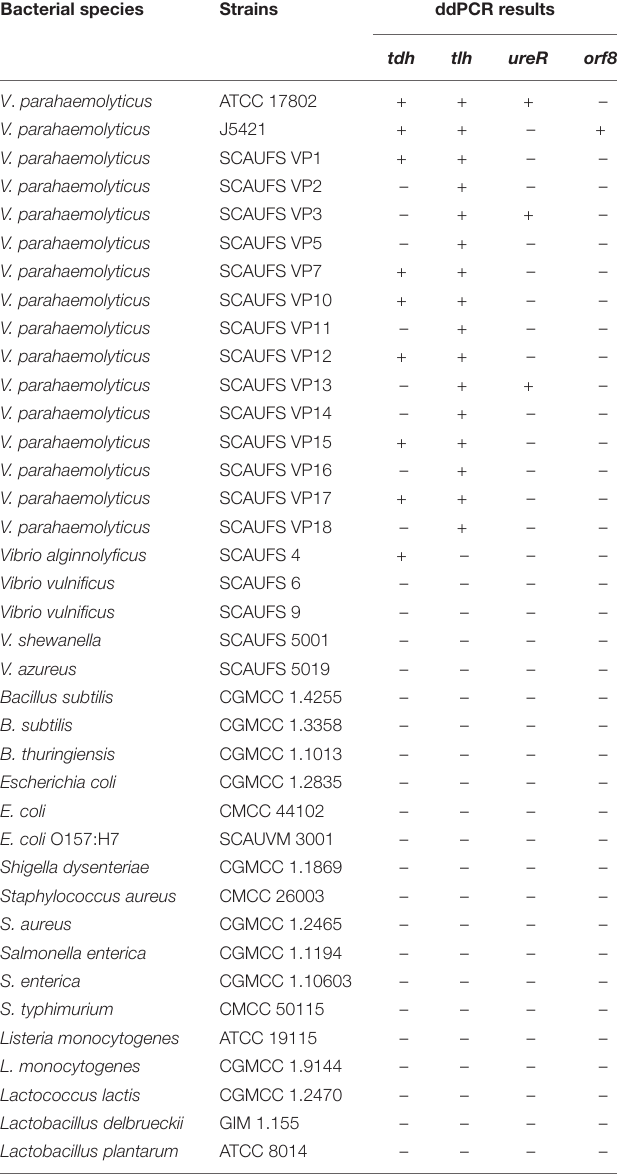
TABLE 1 | Specificity of the ddPCR for tlh , tdh , ureR, and orf8 target genes for different bacterial strains. Bacterial species Strains